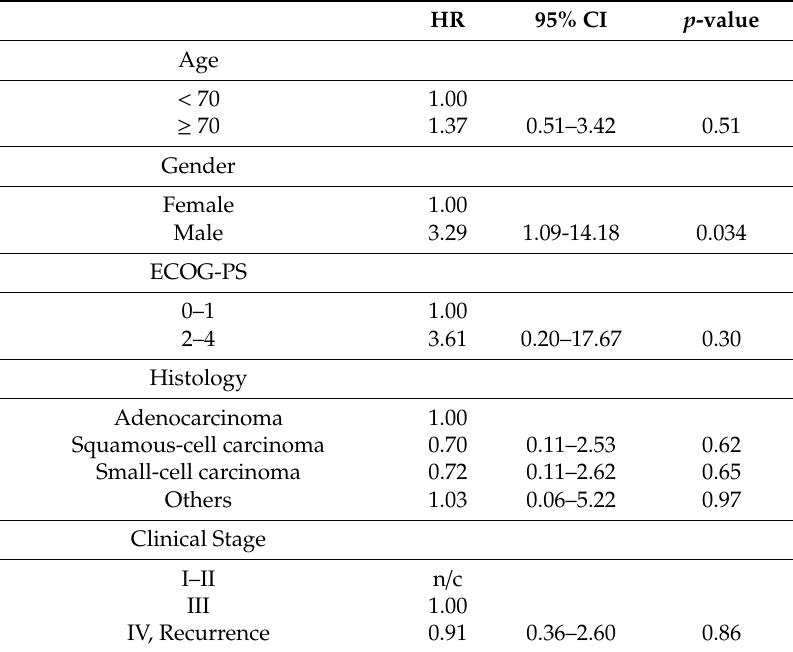
Figure 4. Kaplan–Meier estimated curves of the incidence of anti-cancer drug-induced pneumonia stratified by the high-resolution computed tomography fibrosis score. The Kaplan–Meier estimated curves indicated that the incidence of anti-cancer drug-induced pneumonia is increased in patients with higher high-resolution computed tomography fibrosis scores (HFSs) ( p < 0.0001 according to the log-rank test). Table 2. ( A ) Potential risk factors for anti-cancer drug induced pneumonia ( n = 214) by the simple Cox proportional hazards analysis. ( B ) Influence of other clinical factors to the hazard ratio of HFS by the simple and replaced multiple Cox proportional hazards